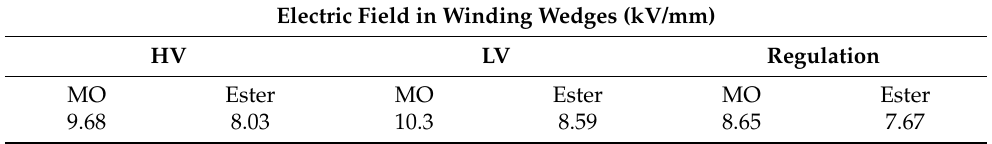
Table 2. Case 1—mineral oil versus ester: comparison.